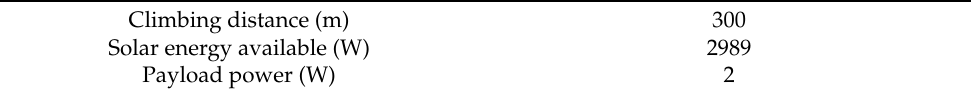
Table 2. Fixed mission parameters of the